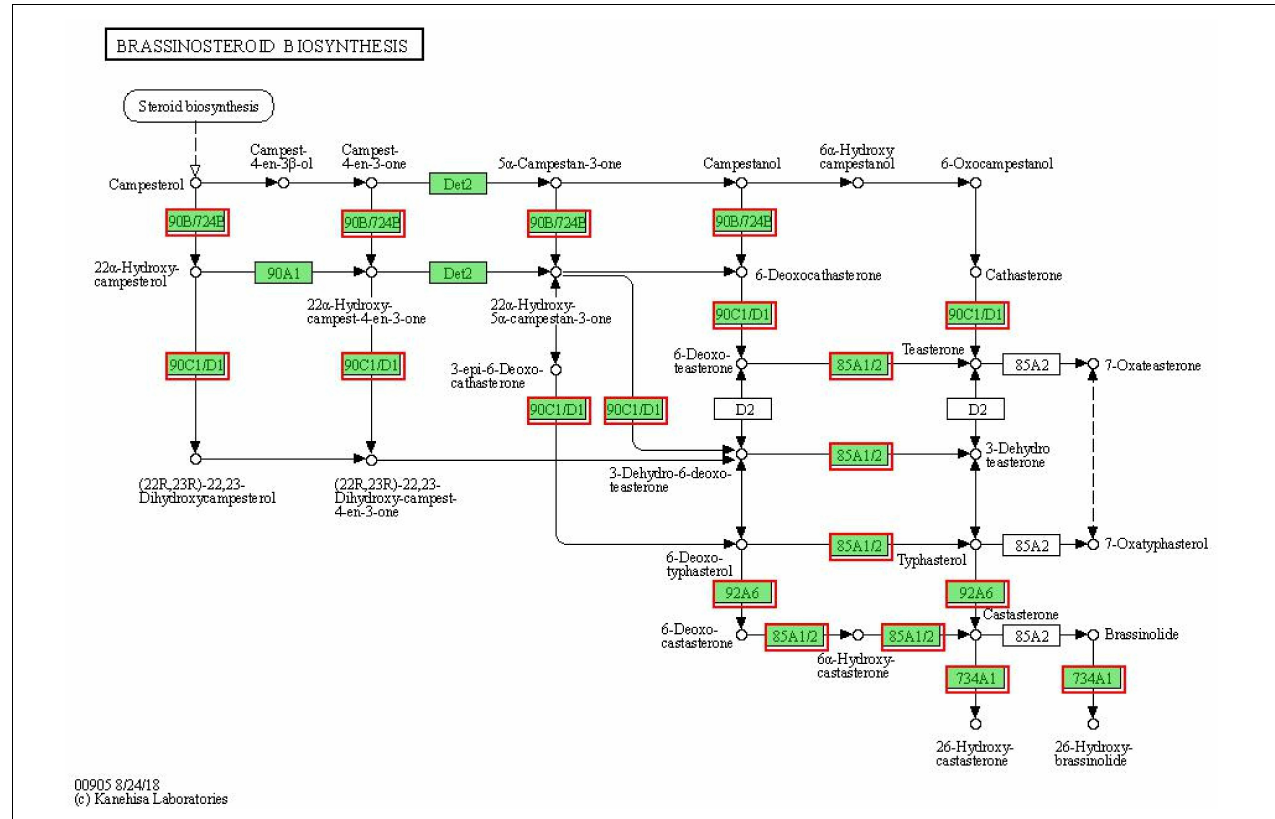
FIGURE 10 | Differentially expressed genes involved the “brassinosteroid biosynthesis” pathway. The red boxes indicated the DEGs were involved in the “brassinosteroid biosynthesis”